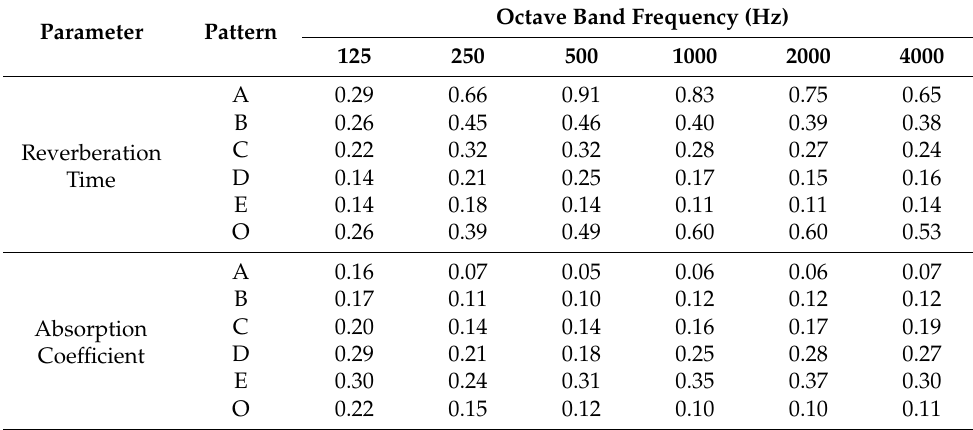
Figure 3. Results of the measurement in the front chamber (O) and five absorption patterns (A–E): ( a ) Reverberation time (s); ( b ) Absorption coefficient.